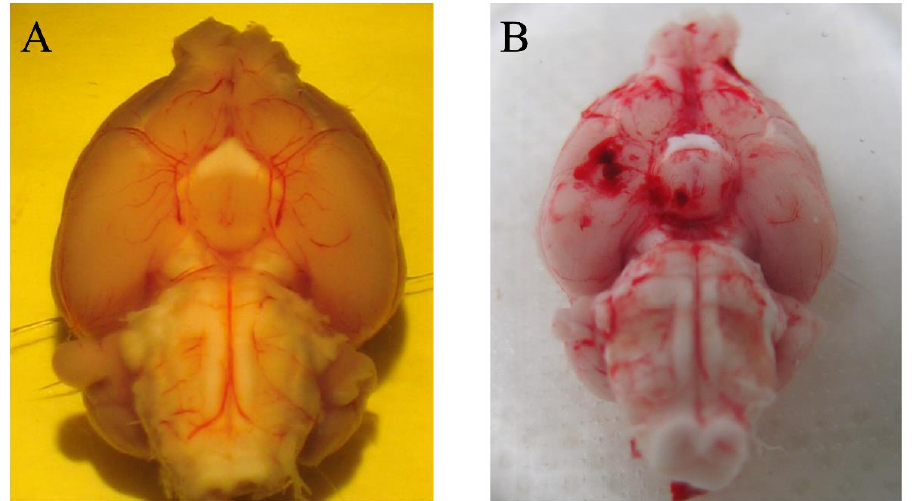
Figure 4. Macroscopic assessment of the brain in the sham and SAH groups. ( A ) shows the sham brain; no signs of subarachnoid bleeding patterns were detected. ( B ) shows the SAH brain with clear blood clots in the basal cisterns.